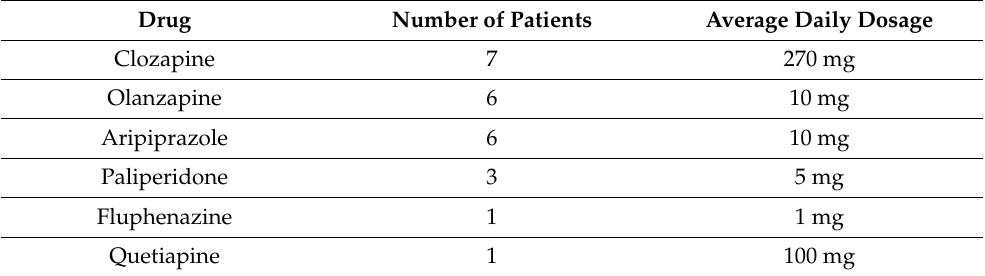
Table 1. Details of the antipsychotic medications undergoing at the time of the experiment in participants with schizophrenia ( N = 24). Drug Number of Patients Average Daily Dosage Clozapine 7 270